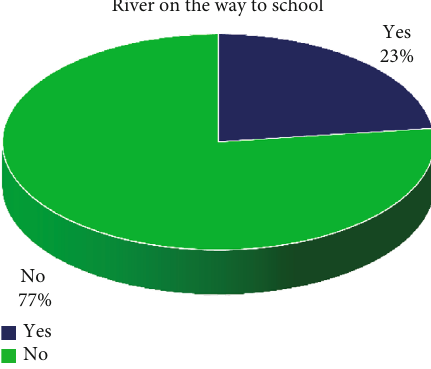
Figure 3: River on the way to